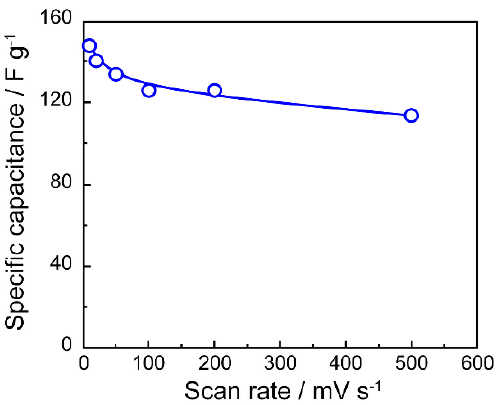
Figure 5. Specific capacitances of erGO/FTO in Et 4 NBF 4 (0.5 M) in propylene carbonate plotted against the scan rate.